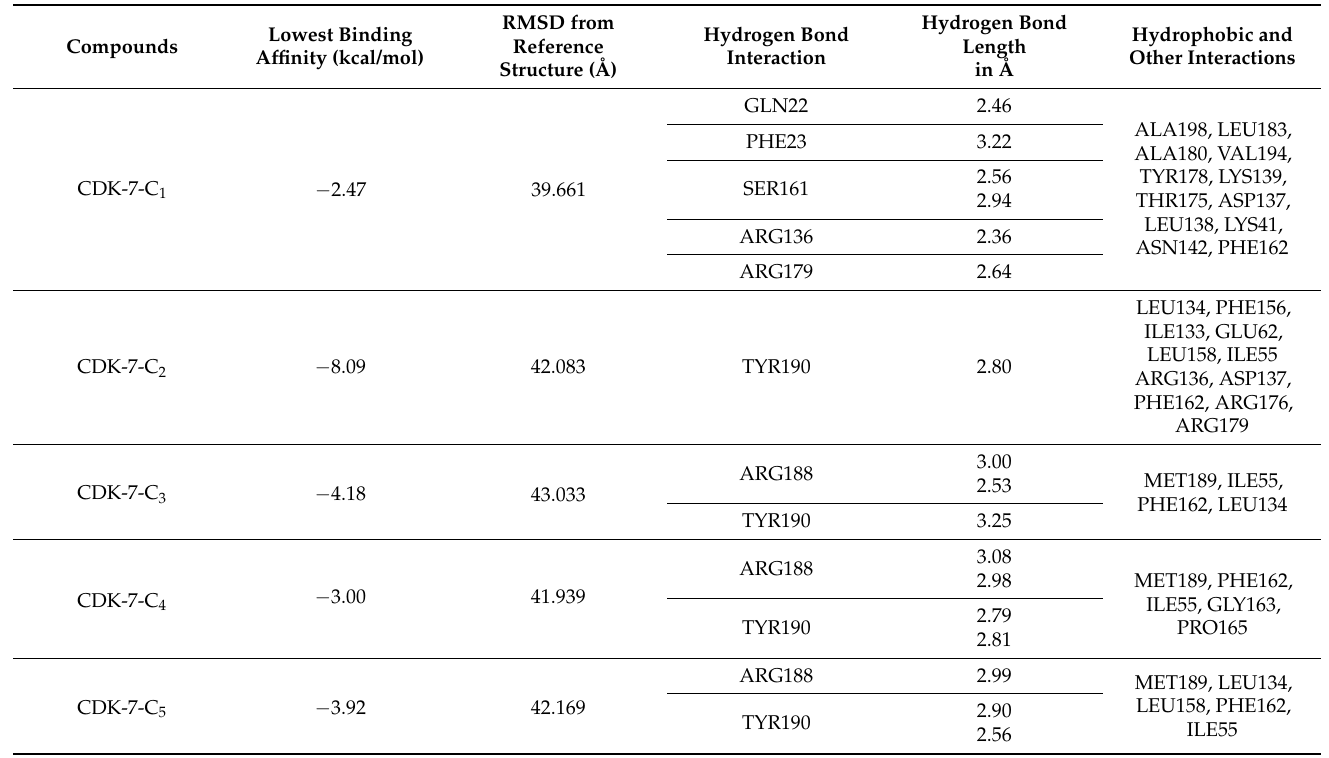
Table 8. The Binding values of Co(II) metal complexes with CDK-7